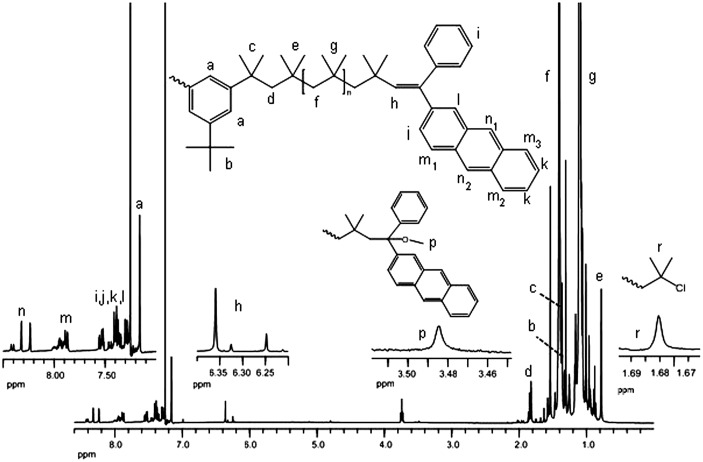

1H NMR spectrum of APE-PIB-APE-1.